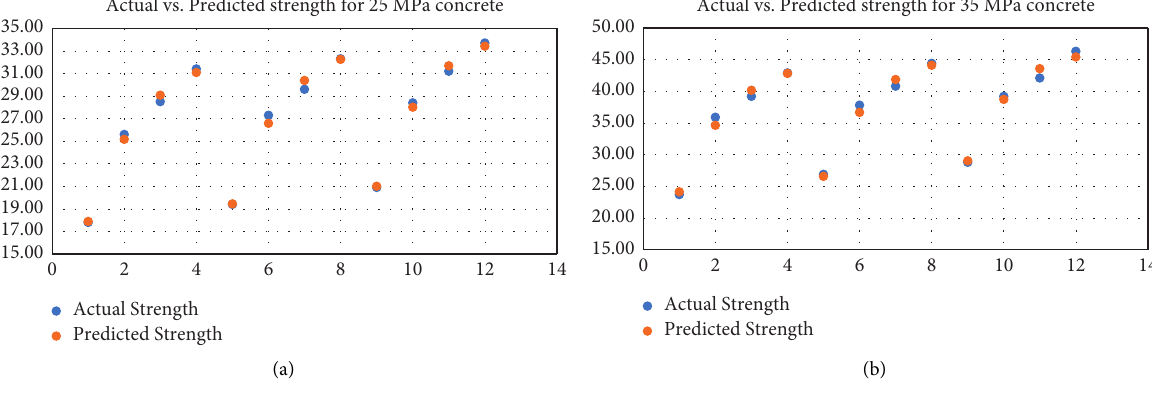
Figure 11: Plot of actual vs predicted strength.